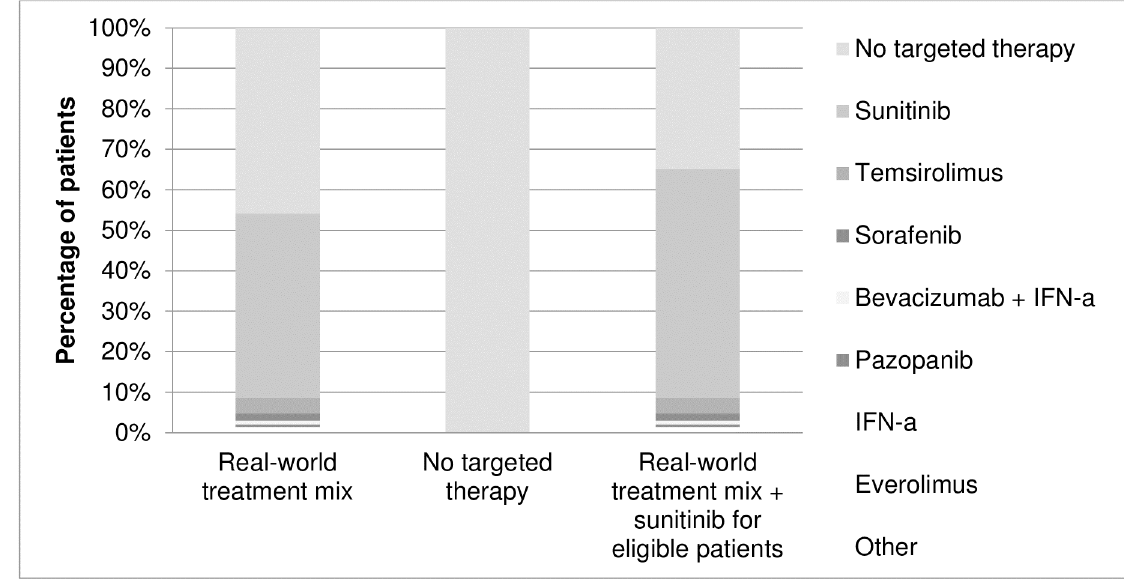
Fig 1. First-line therapies in the various treatment